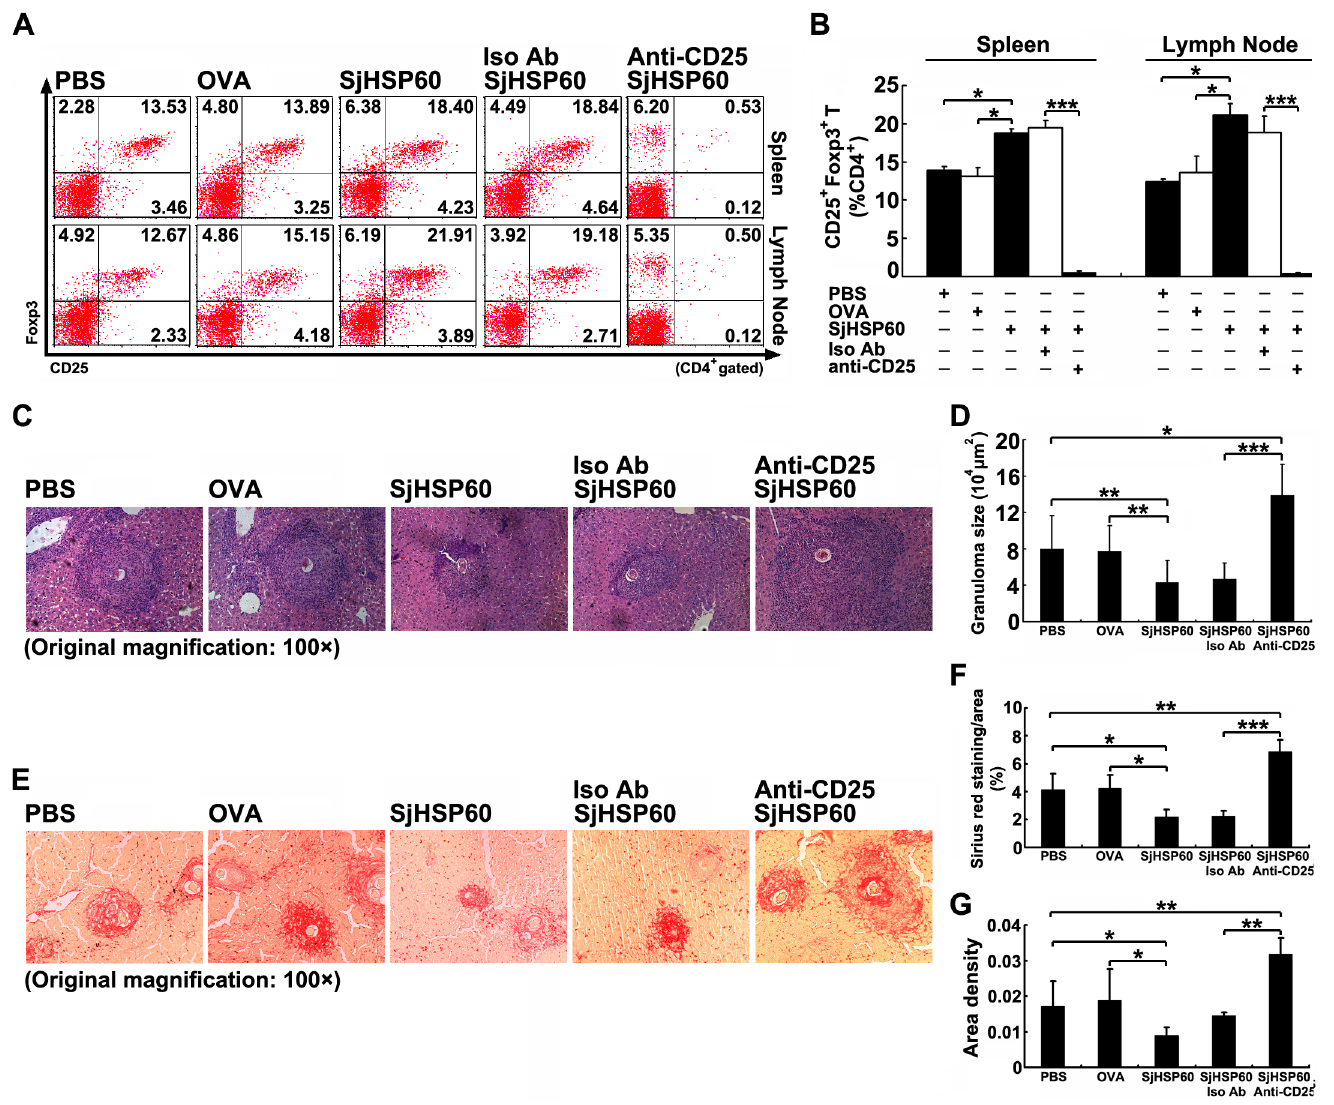
Fig 3. SjHSP60 limits hepatic immunopathology in S . japonicum infected mice by further increasing Tregs. (A and B) Mice were immunized with SjHSP60 and/or injected intraperitoneally with anti-CD25 PC61 depletion mAb to in vivo deplete Tregs. Control mice received normal isotype antibody (rat IgG1). Single cell suspension was stained with antibodies against CD4, CD25, and Foxp3 as described in Materials and Methods. CD4 + CD25 + Foxp3 + Tregs were FCM analyzed and cells were gated on CD4 + T cells. FCM plots are representative of three independent experiments. (C) Livers sections were H&E stained to reveal granulomas (original magnification, 100×). Images are representative of three independent experiments. (D) Granuloma areas were measured. (E) Livers sections were stained by Sirius red to reveal granulomas (original magnification, 100×). (F and G) Quantification of Sirius red staining was performed by Image-Pro Plus software and represented as percentage of stained-area per total area (F) and area density (G) . Data are means ± SD of 15 mice from three independent experiments. * P < 0.05, ** P < 0.01, *** P <